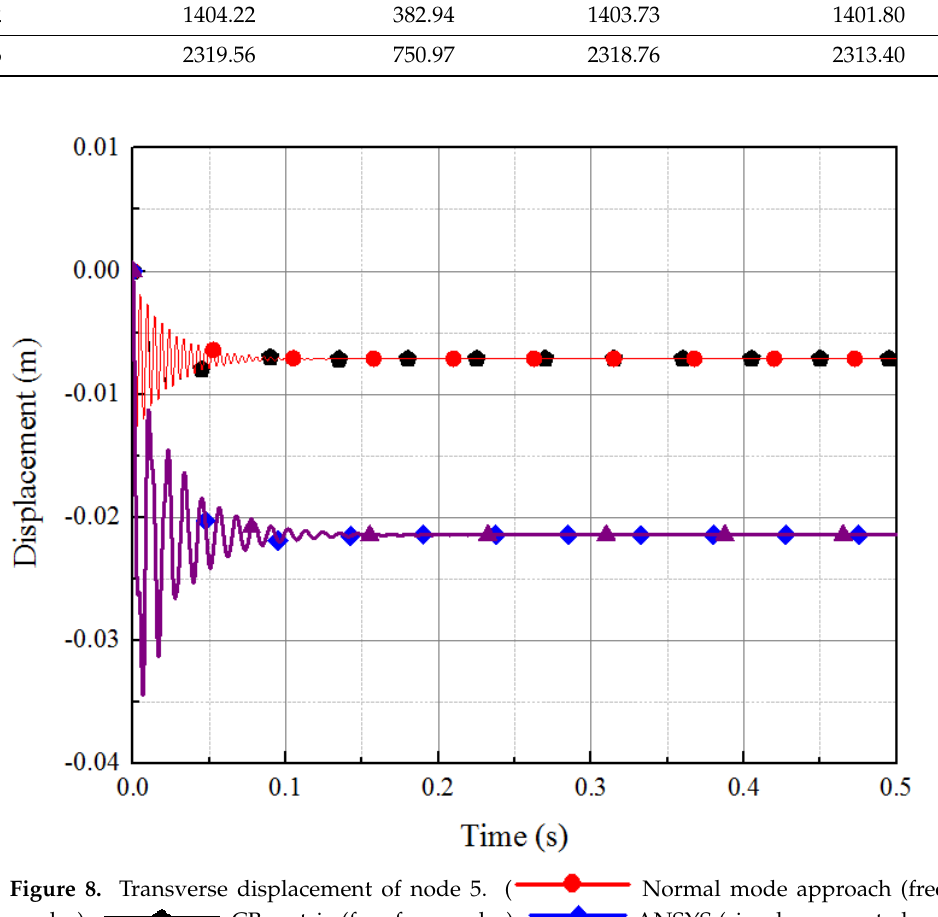
Figure 8. Transverse displacement of node 5. ( Normal mode approach (free-free modes), CB matrix (free-free modes), ANSYS (simply-supported modes), and Improved CB matrix (simply-supported modes)).